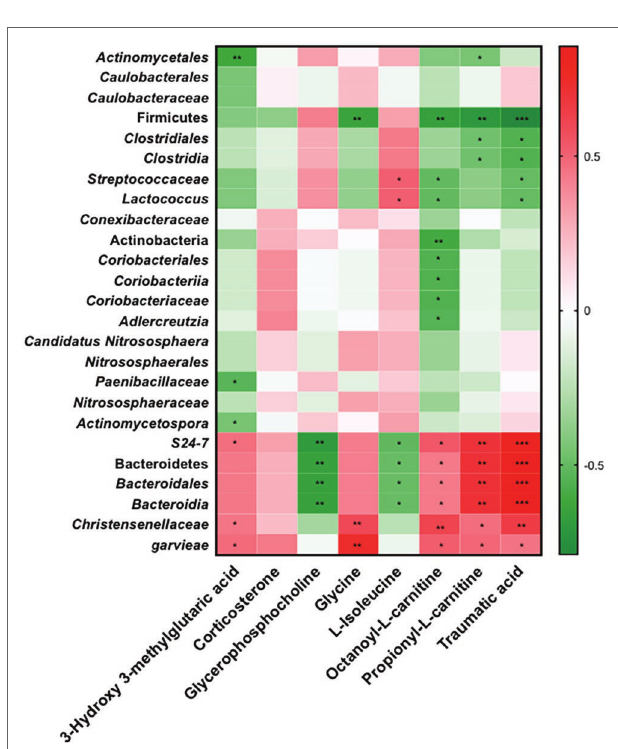
FIGURE 6 | specific bacteria at the family level of taxonomic cladograms. LEfSe was used to compare the abundances of all detected bacterial taxa among four groups. The differentially abundant taxa shown in the histogram are significantly different by the Kruskal-Wallis test and have an linear discriminant analysis (LDA) score of greater than 3. n = 5 per group. Networks of co-occurring families showed associations among ND, HFD, HFDM1 and HFDAPS1. Circles symbols represent bacterial families positive (yellow) or negative (blue) correlated with body weight gain. The edges represent the strength of positive (green) or negative (red) correlations among the families. The data are expressed as the mean ± SEM. Labeled means without a common superscript letter differ. Values of p was calculated by KruskaleWallis test, ✽ p <